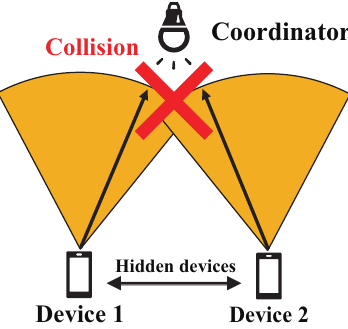
Figure 2. The mechanism of the hidden device problem in VLC networks.